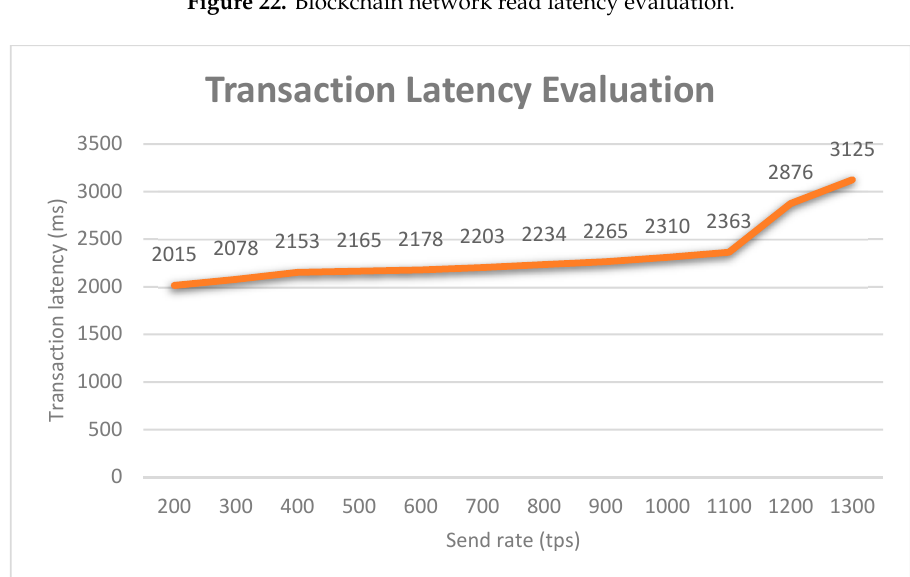
Figure 23. Blockchain network transaction latency evaluation.